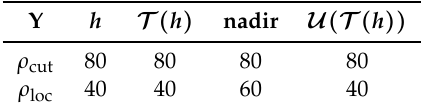
Table A2. The localization cutoff ρ cut and radius ρ loc , in km, for the respective observations